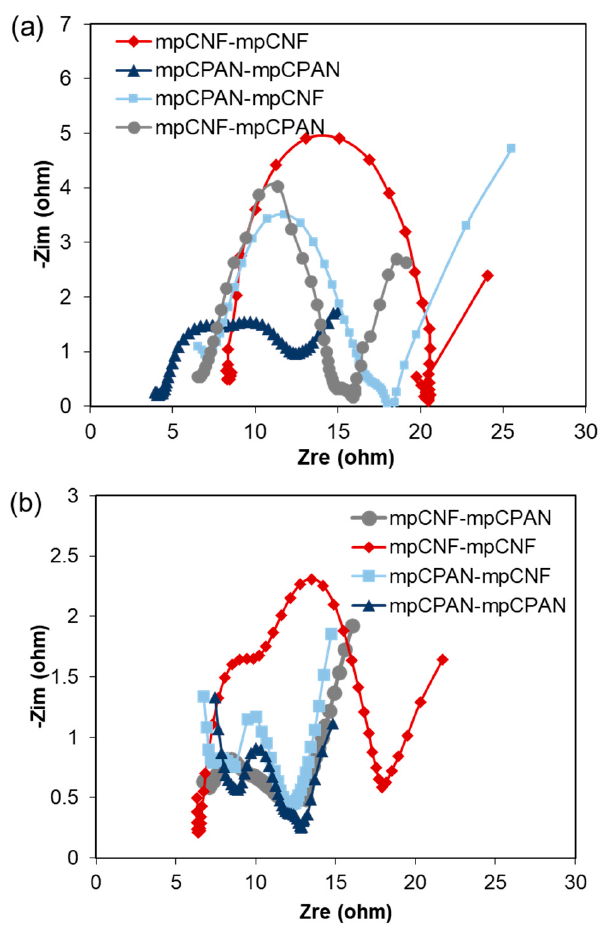
Figure 13. ( a ) EIS Spectra of fresh cells; ( b ) EIS Spectra of discharged cells after 100 cycles. High-resolution S 2p and N 1s spectra of the cathode and interlayer of each system were examined after 100 cycles and are shown in Figure 14a–d. The cells were fully